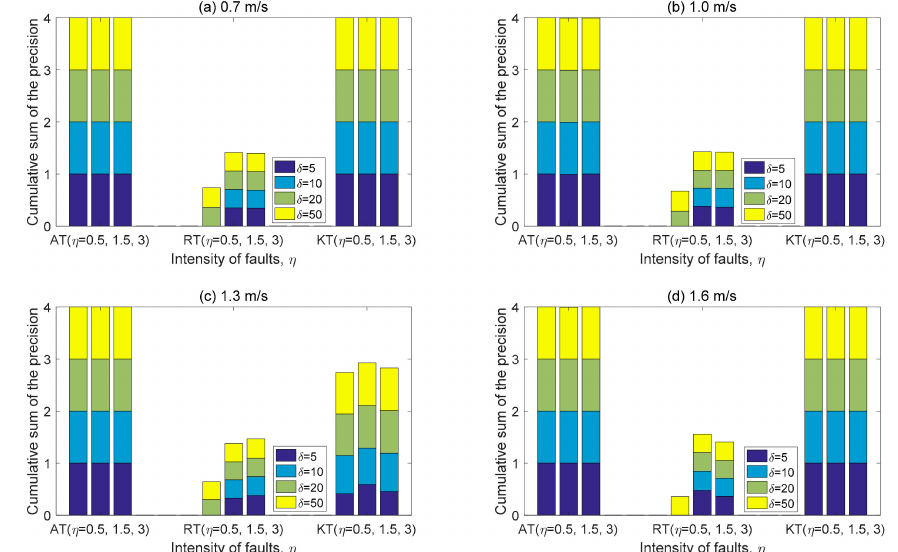
Figure 12. Precision according to each duration as a function of noise fault intensity: ( a ) Cumulative sum of the precision at 0.7 m/s of Jackal UGV; ( b ) Cumulative sum of the precision at 1.0 m/s; ( c ) Cumulative sum of the precision at 1.3 m/s; ( d ) Cumulative sum of the precision at 1.6